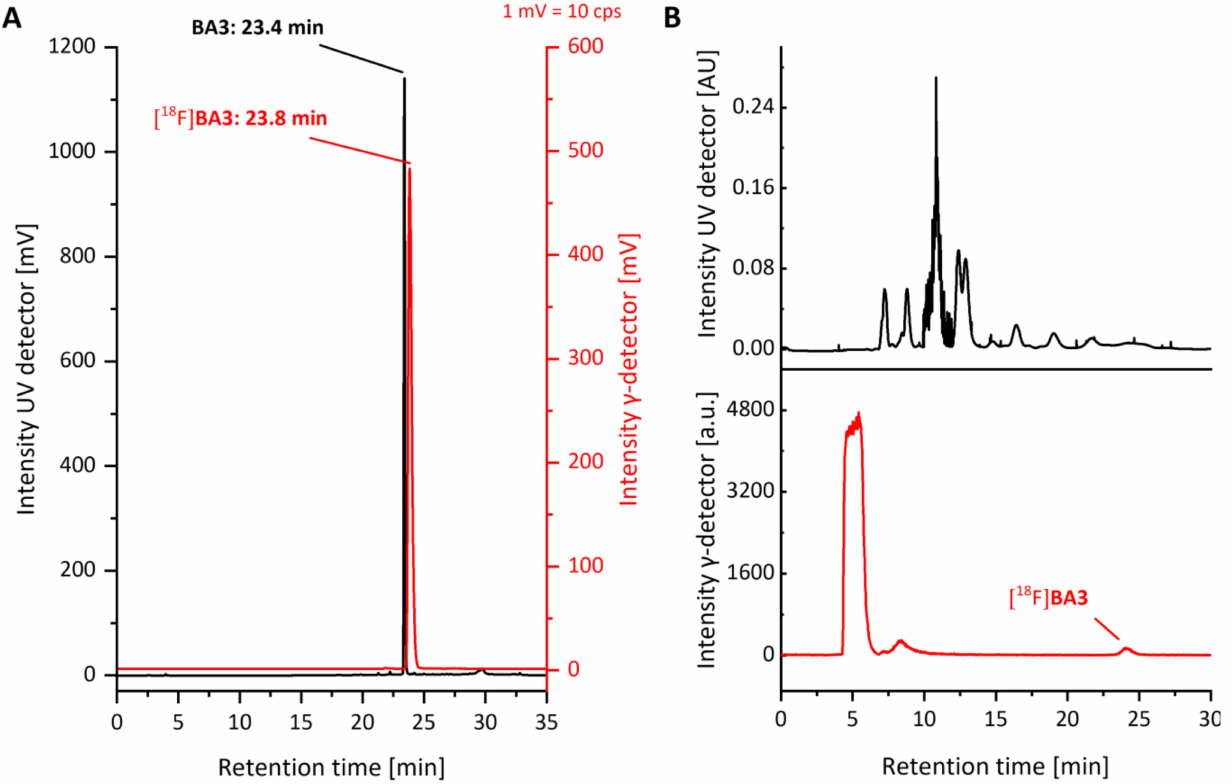
Figure 2. ( A ) Analytical radio- and UV-RP-HPLC chromatograms of formulated [ 18 F] BA3 spiked with the corresponding reference compound BA3 (ReproSil-Pur 120 C18-AQ column (250 × 4.6 mm, 5 µ m), Gradient MeCN/20 mM NH 4 OAc aq. (see quality control), flow rate: 1 mL/min; red: radio- RP-HPLC chromatogram, black: UV-RP-HPLC chromatogram); and ( B ) Radio- and UV-RP-HPLC chromatograms obtained for the isolation of [ 18 F] BA3 by semipreparative RP-HPLC (ReproSil- Pur 120 C18-AQ (250 × 10 mm, 10 µ m), 40% MeCN/20 mM NH 4 OAc aq. , flow rate: 4 mL/min; AU = absorption unit, a.u. = arbitrary unit; red: radio-RP-HPLC chromatogram, black: UV-RP-HPLC